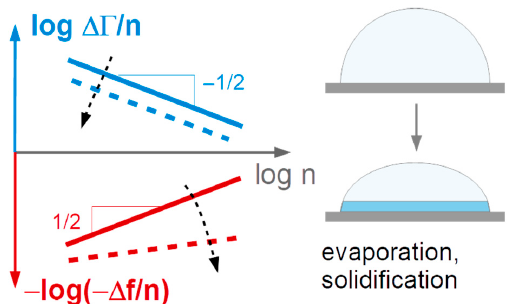
Figure 3. ( Top ) Shifts of frequency and bandwidth for the impact of an individual droplet from Figure 3. As drying proceeds, the ratio ΔΓ /( −Δ f ) decreases, while the power law exponent of −Δ f ( n ) the four types of solutions indicated in the titles. ∆ f and ∆Γ have been normalized to n 1 / 2 because increases. This can be explained with the formation of a solid film at the substrate surface. In the limit this scaling makes the data from di ff erent overtones overlap. The dye concentrations were 0.5 wt% of the dry fi lm, the ratio ΔΓ /( −Δ f ) goes to zero and – Δ f scales as n (not as n 1/2 , as in the case of the (Food Black 2) and 1.5 wt% (fluorescein) in water and 30:30:40. For the 30:30:40-fluid, drying is Newtonian liquid.) The deposition of solid matter at the substrate surface drives the system in this slow ( > 20 s). Droplets based on water dry out in less than 2 s. ( Bottom ) The ratio ∆Γ / ( − ∆ f ) always direction. Sensors 2020 , 20 , x FOR PEER REVIEW decreases with time.